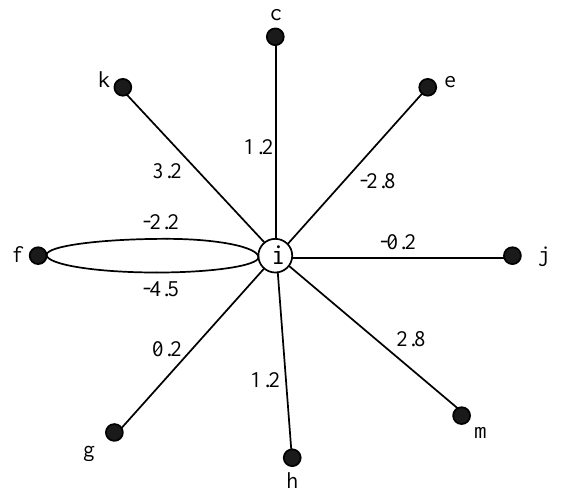
Figure 4. Local conflict graph (LCG) of node i